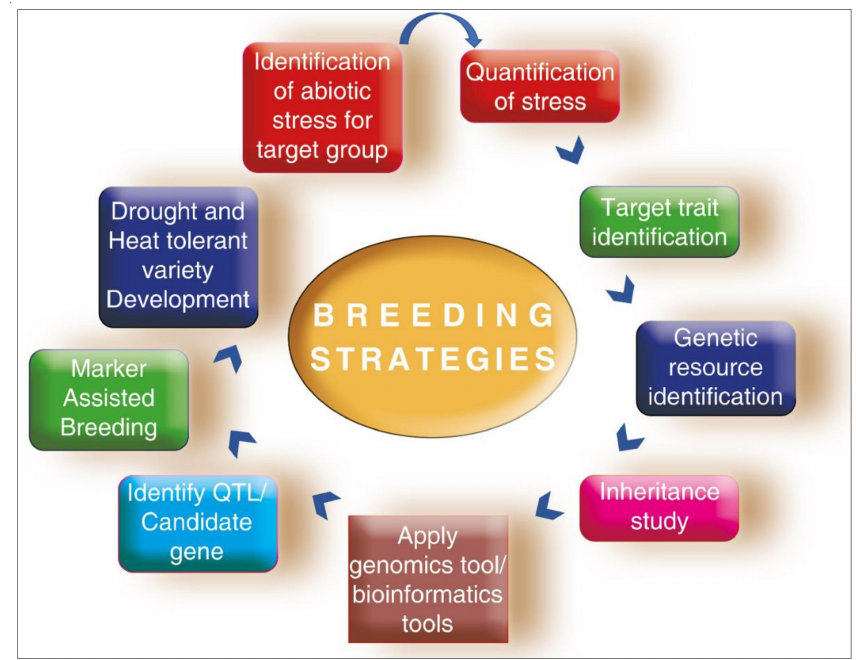
Figure 1. Breeding strategies deployed for cool-season legume breeding. Inheritance